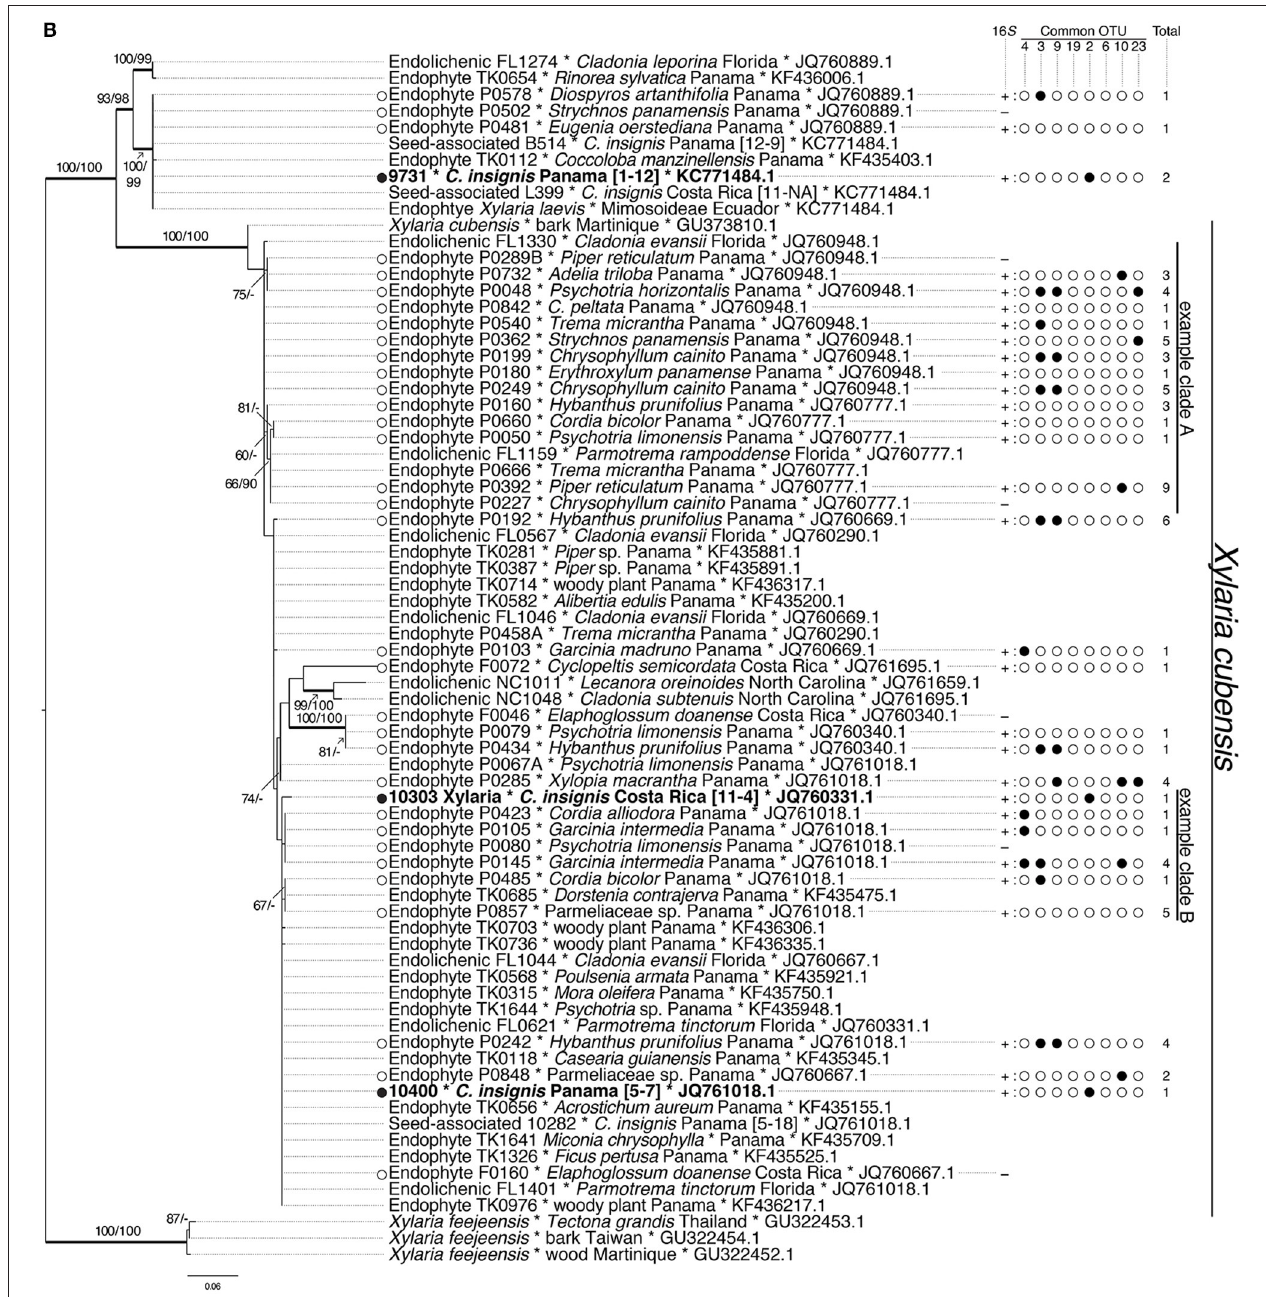
FIGURE 1 | Phylogenetic relationships among representative seed-associated and foliar endophytic fungi screened for EHB. (A) Fusarium solani species complex (FSSC, Nectriaceae) based on ITS rDNA–partial LS rDNA, RPB2 , and TEF ; (B) Xylaria “PO” (Xylarioideae) based on ITS rDNA. Topologies are best trees from maximum likelihood analyses. Branch support values are maximum likelihood bootstrap (MLBS; n = 1000 replicates) and Bayesian posterior probabilities (BPP; 6 million generations; burn-in of all trees with a standard deviation of split frequencies ≥ 0.01). Thickened branches are those with ≥ 70 MLBS and ≥ 95 BPP values. Branches lacking support values have values < 60 (MLBS) and < 80 (BPP). Taxon labels for tropical seed-associated fungi examined here are bolded and preceded by black circles, and those for tropical foliar endophytic fungi are preceded by white circles. Taxon labels for all fungi examined here include host plant species names, geographic locations, and GenBank accession numbers for top BLAST matches based on ITS rDNA. Signs indicate if EHB were detected ( + ) or not ( − ) during screening. Filled circles to the right of taxon labels indicate the presence of one of eight most common 16 S OTUs, and numbers indicate the total number of unique 16 S OTUs detected in each fungal isolate. Names for reference strains include hosts/substrates and geographic origins (when available) as well as GenBank accession numbers. C = Cecropia . Double- and triple-hash marks indicate branches shortened to one-half and one-quarter of their length, respectively. Named clades provide examples of the diversity and distribution of EHB OTUs among host fungi varying in ecological mode (e.g., seed-associated Fusarium keratoplasticum , foliar endophytic Xylaria cubensis ), host plant species (e.g., within X. cubensis example clade A: fungi from Chrysophyllum cainito vs. other host plants), geographic location (e.g., within X. cubensis : fungi from Costa Rica vs. Panama), and close relatives (e.g., within FSSC haplotype 25: only two pairs of fungi share EHB OTUs). In general, we detected similar and diverse EHB OTUs among fungi consistent- and varying in each of the above factors.